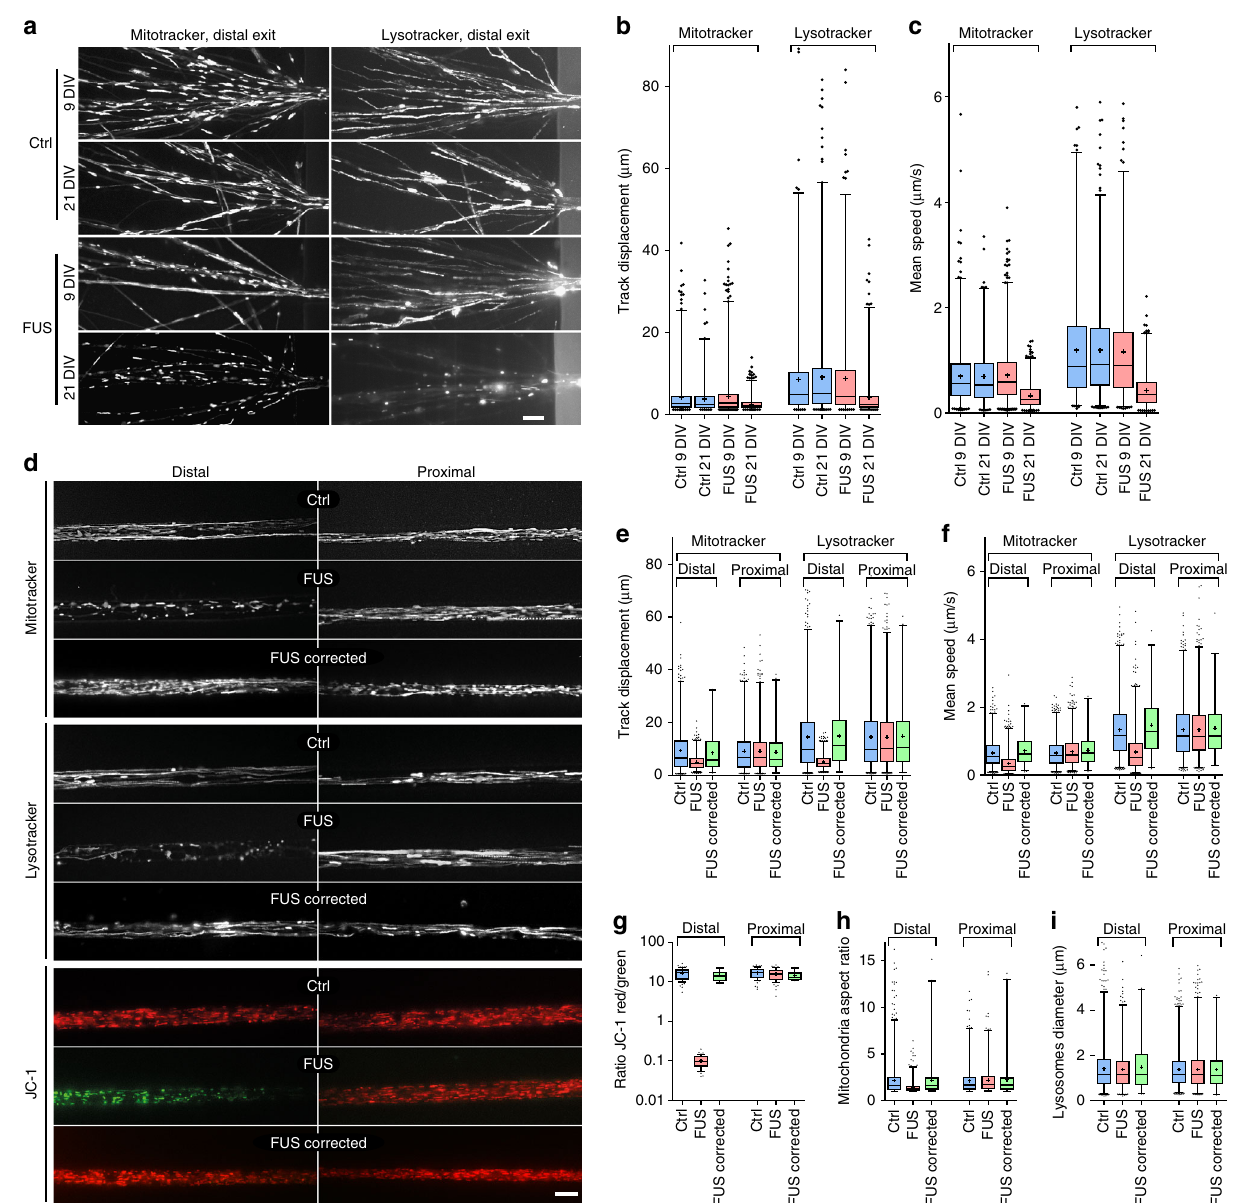
Fig. 4 MNs develop traf fi cking defects of mitochondria and lysosomes over time along with loss of mitochondria function in distal axons. a FUS MN movies of shorter 150 µ m-MFC ’ s at earlier maturation stage (9 DIV) versus standard endpoint time (21 DIV). Shown is the motility of mitochondria (left, Supplementary Movie 1) and lysosomes (right, Supplementary Movie 2) at the distal exit as maximum intensity projection. b , c Organelle tracking analysis as box plots, Ctrl: FUS-GFP WT, FUS: FUS-GFP P525L as described in Table 1. d FUS MN movies: distal organelle arrest and loss of mitochondrial membrane potential at 21 DIV in 900 µ m-MFC ’ s (representative examples: Ctrl1 versus FUS R521C), bar: 10 µ m (Supplementary Movie 3). Note the rescue in isogenic FUS R521C corrected control cells. Shown is maximum intensity projection except for JC-1 movies, in which fi rst frame of movie is shown. e – i Organelle tracking ( e , f ), mitochondrial membrane potential ( g ) and shape ( h , i ) analyses as box plots, batch analysis of Ctrl1-3 (Ctrl) and FUS R521C, R521L, R495QfsX527 (FUS) as described in Table